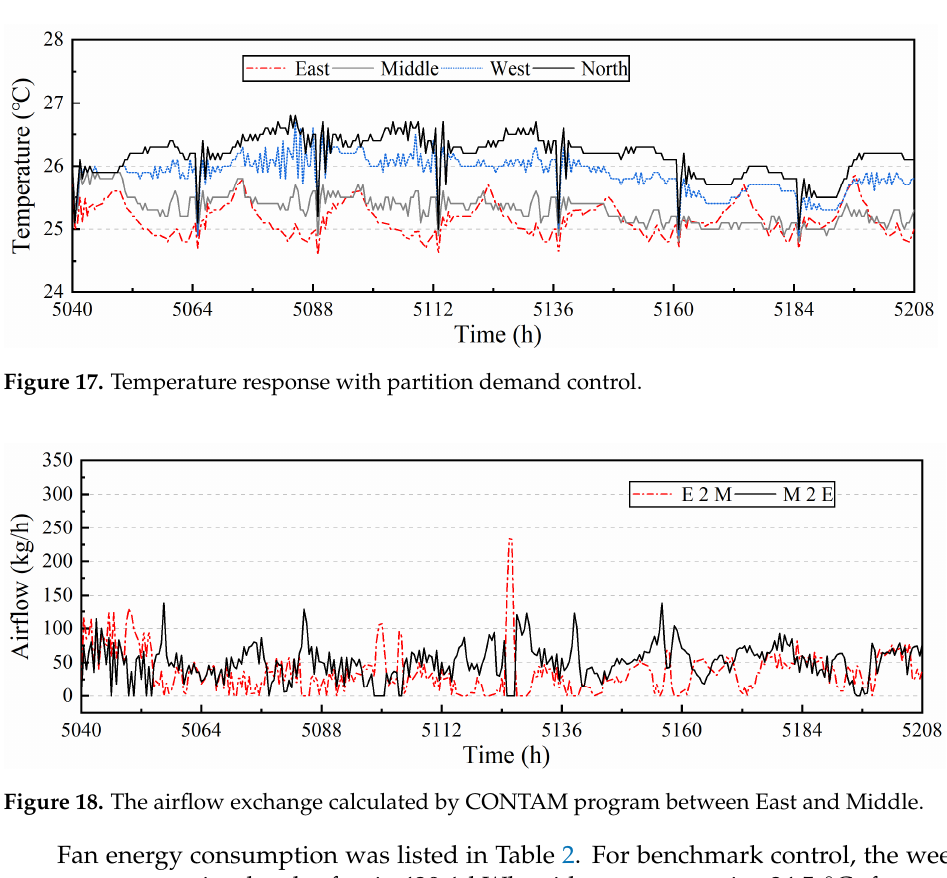
Figure 17. Temperature response with partition demand control.